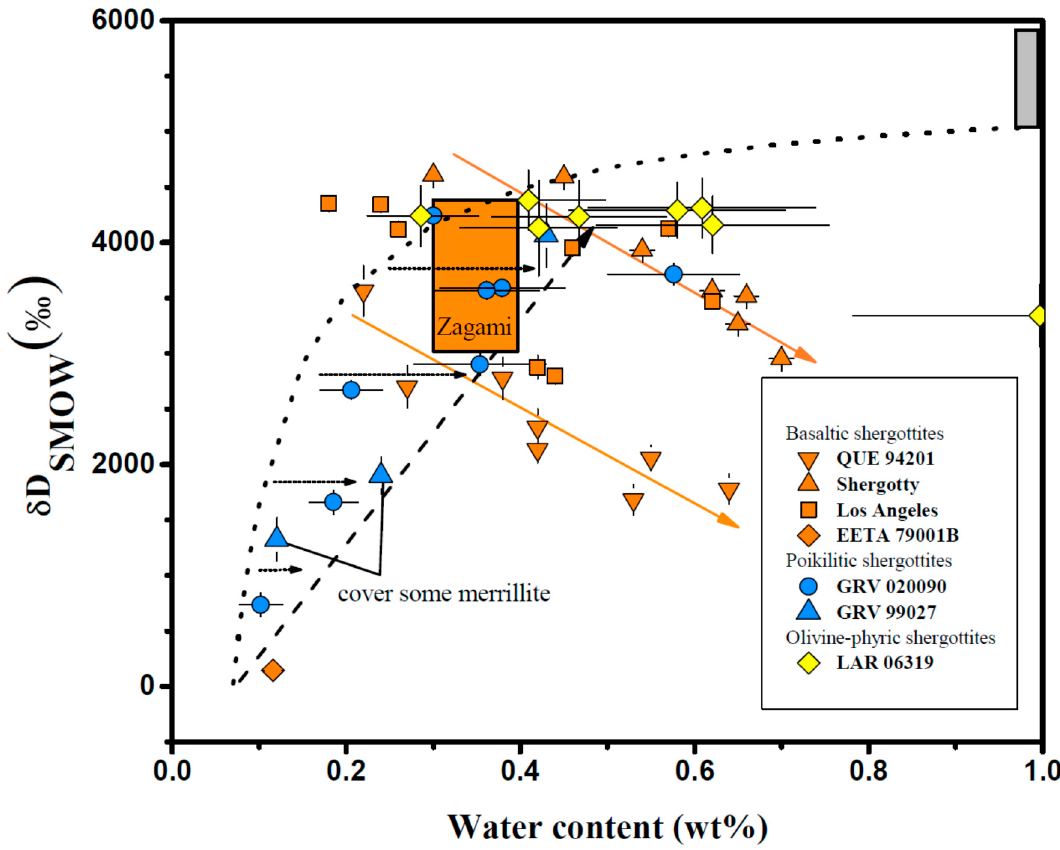
Figure 2. The relationship between water content and δ D values in shergottite apatite grains. Poikilitic shergottites, GRV 020090, and GRV 99027, display a positive trend. In contrast, basaltic shergottites, QUE 94201, Shergotty, Los Angeles, and EETA 79001B show a negative correlation between H 2 O and δ D. Most apatite grains from olivine-phyric shergottite LAR 06319 have similar δ D values with water content varying from ~0.3 to ~0.6 wt. % except for a spot having a water content of ~1.0 wt. % and a δ D of ~3300 ‰ . The dash line shows the combined effect of the fractional crystallization (horizontal arrows) and assimilation (dot line) of Martian crustal materials with magma ascension [67] . QUE 94021 from [73] , Shergotty from [51,61] , Los Angeles from [61] , EETA 79001B from [59] , probably covering on adjacent mafic phases, GRV 020090 from [67] , GRV 99027 from [63] , LAR 06319 from [69] , Zagami from [58] .